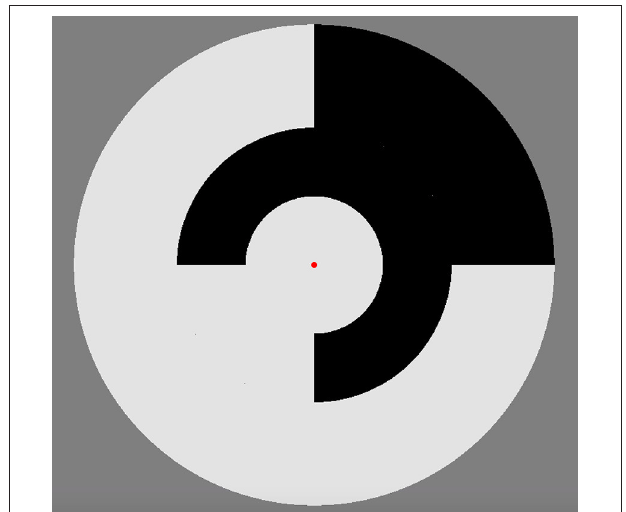
FIGURE 1 | Multifocal stimulus employed for the VEP recordings. A central 7 ◦ circular disk was surrounded by two annuli each divided into four separate patches. Each patch fluctuated between two luminance levels on the basis of a pseudorandom m-sequence, with the sequence for each patch maximally shifted, resulting in stimuli that are mutually